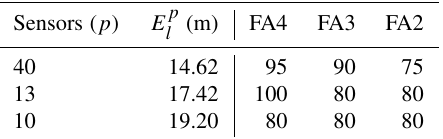
Table 3. Statistics for the source reconstruction results from each monitoring network. Here, E p is the averaged location error for all l 20 trials corresponding to each network. FA g represents the per- centage of trials in which the source intensity is estimated within a factor of g